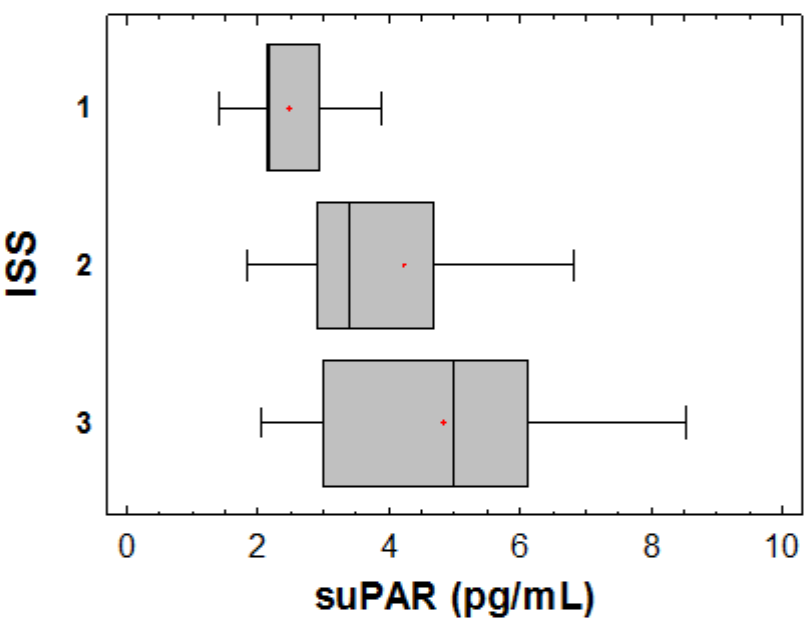
Figure 2. suPAR levels according to MM International Staging System (ISS) stage (Kruskal-Wallis Median Test, p = 0.002).